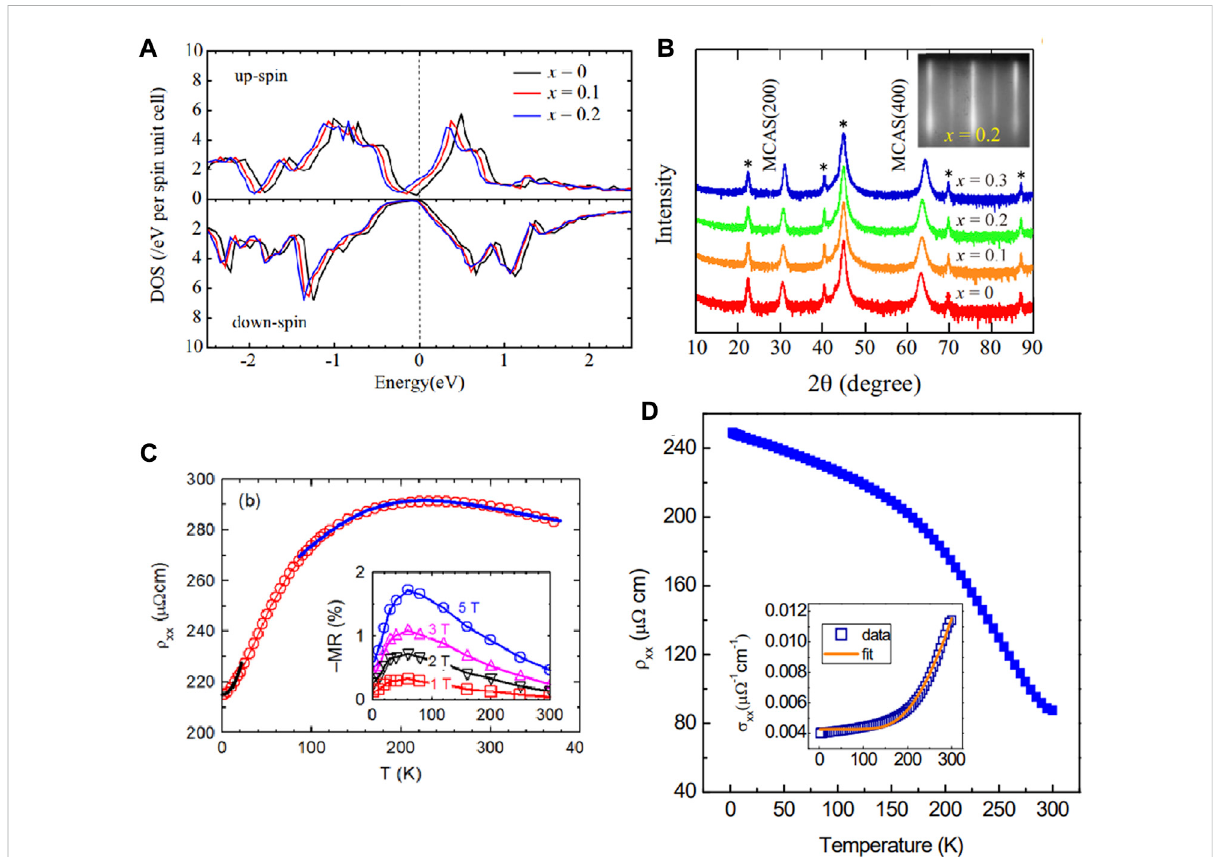
FIGURE 2 (A) Density of states for Mn 2 CoAl 1-x Si x (x = 0, 0.1, and 0.2). (B) The θ -2 θ x-ray diffraction of the Mn 2 CoAl 1-x Si x fi lms. (C) Resistivity versus temperature (red circles). Insert shows magnetoresistance at several magnetic fi elds. (D) The relationship between the resistivity and temperature was measured at zero magnetic fi elds. The inset shows the fi tting of conductivity. Reproduced from Refs. (Jamer et al., 2013; Xu et al., 2014; Arima et al., 2018) with